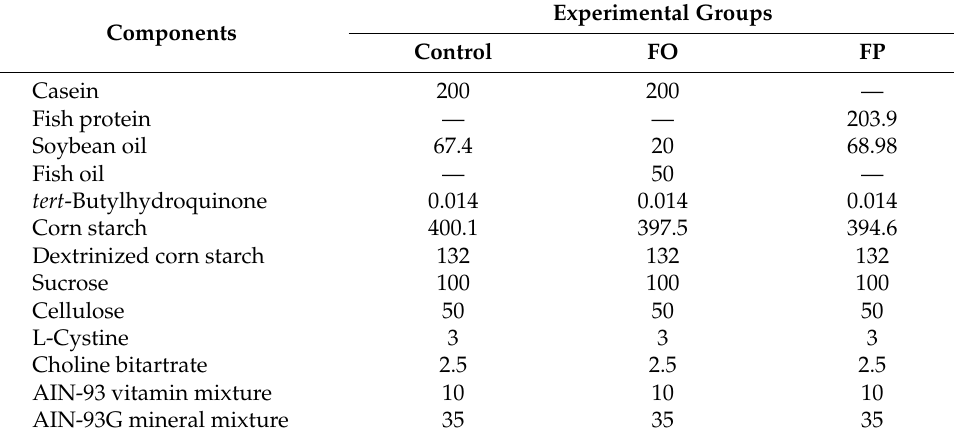
Table 3. Composition of experimental diets (g/kg).